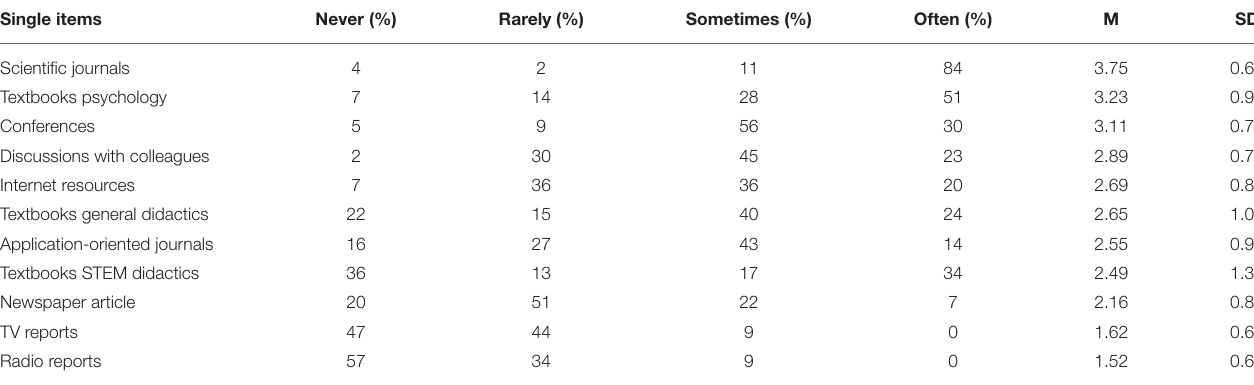
TABLE 6 | Descriptive statistics for sources of evidence: percentage of nominations, mean scores (M), and standard deviation (SD) of the single items. Single items